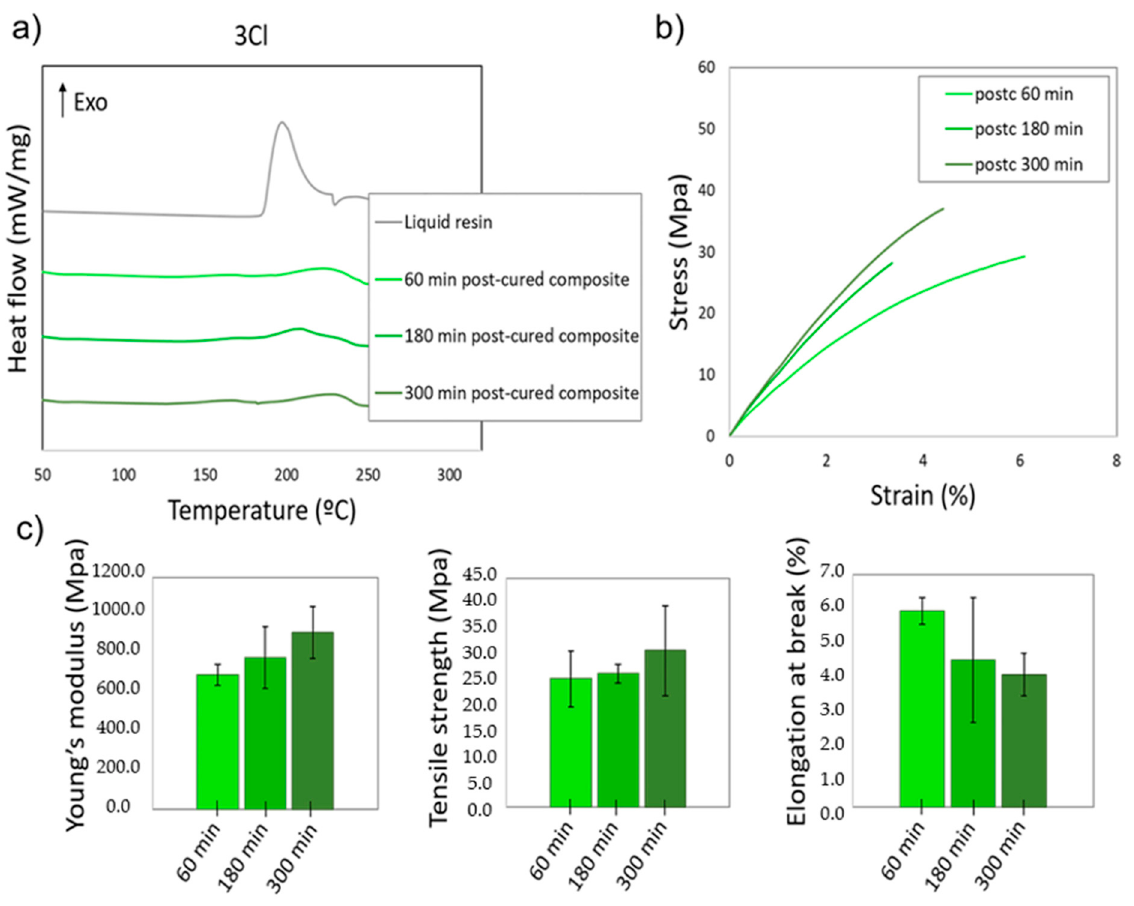
Figure 7. ( a ) DSC thermograms of the liquid resin and 3Cl composites subjected to UV post-curing processes at 60 °C and different times: 60, 180 and 300 min; ( b ) typical stress-strain curves and ( c ) average Young’s modulus, tensile strength, and elongation at break of the different post-cured nanocomposites.